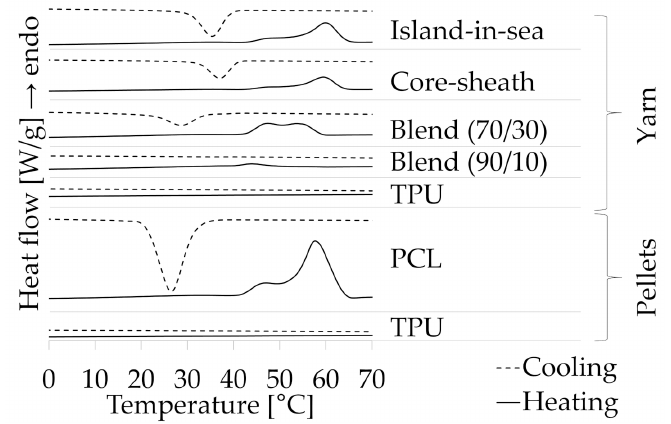
Figure 4. Di ff erential scanning calorimeter (DSC) heating (solid lines) and cooling (dashed lines) curves of pellets and yarn